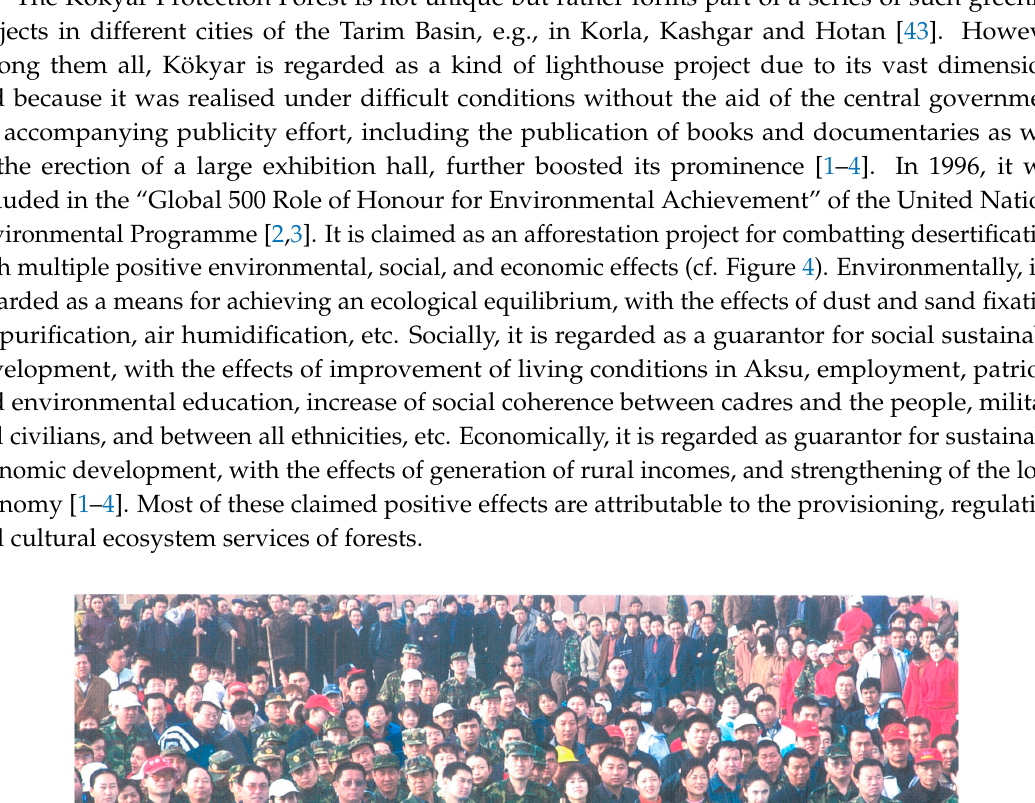
Table 1. Overview of the present four project periods of Kökyar Protection Forest. Bold numbers: sums of single project areas; italic numbers: provisional figures of the planned extent. 1.